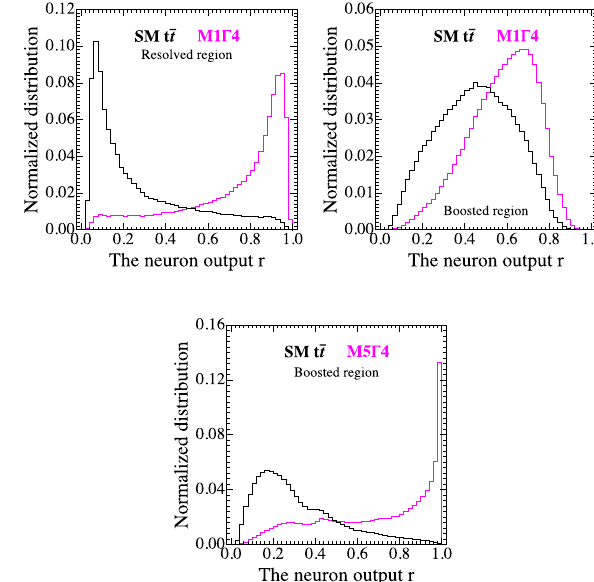
Fig. 2 The final DNN output r distributions that we use to obtain cross section upper limits. Benchmark cases with Γ ρ / M ρ = 40% and t ¯ t